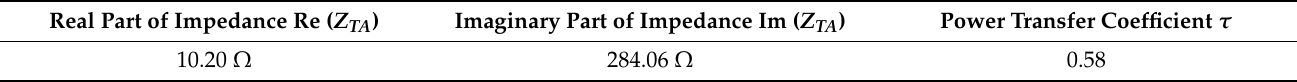
Table 10. Numerical calculations of microelectronic module at 866 MHz.